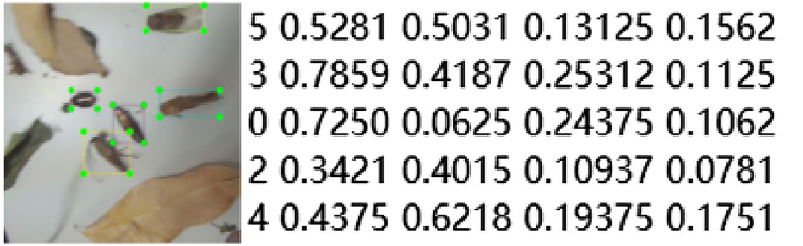
Figure 3. Schematic diagram of image annotation and coordinate information.